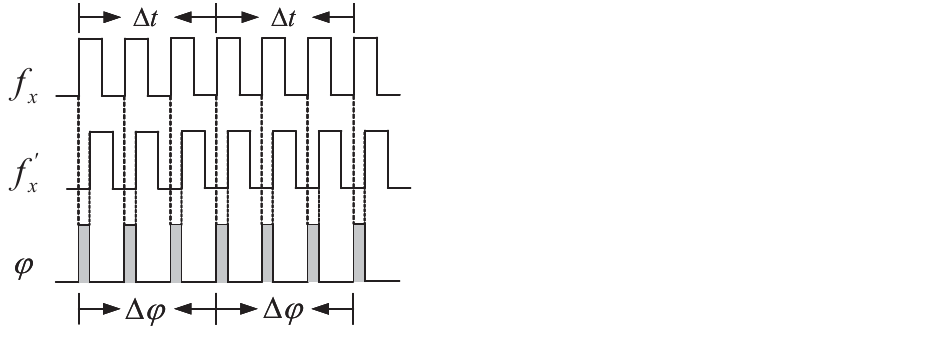
Figure 7. Variation law of phase difference between two signals with equal frequency and different initial phase.